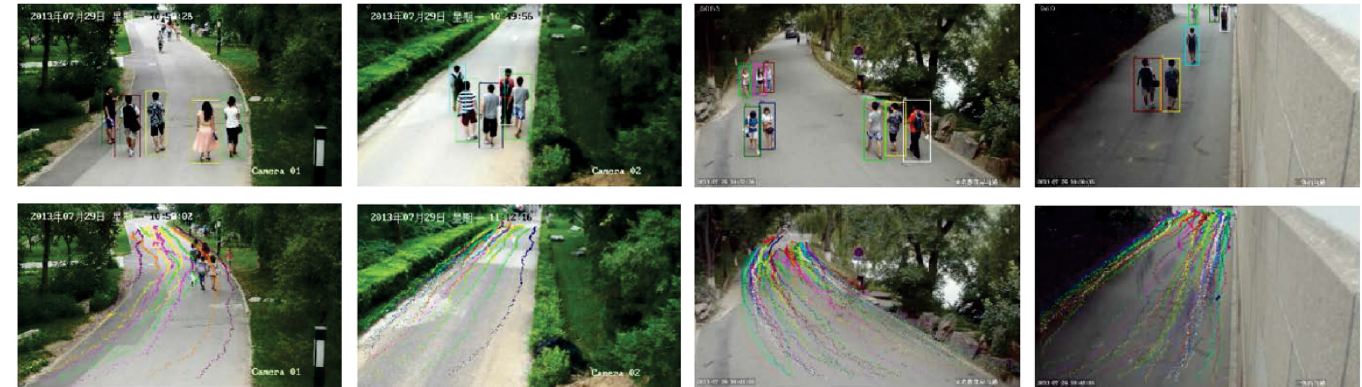
Fig 8. Examples from the PKU dataset: The first row shows sample images with labelled pedestrians in cameras HD01, HD02-1, WMHD-1 and YTX-1, and the second row shows the corresponding pedestrian centroid trajectory.